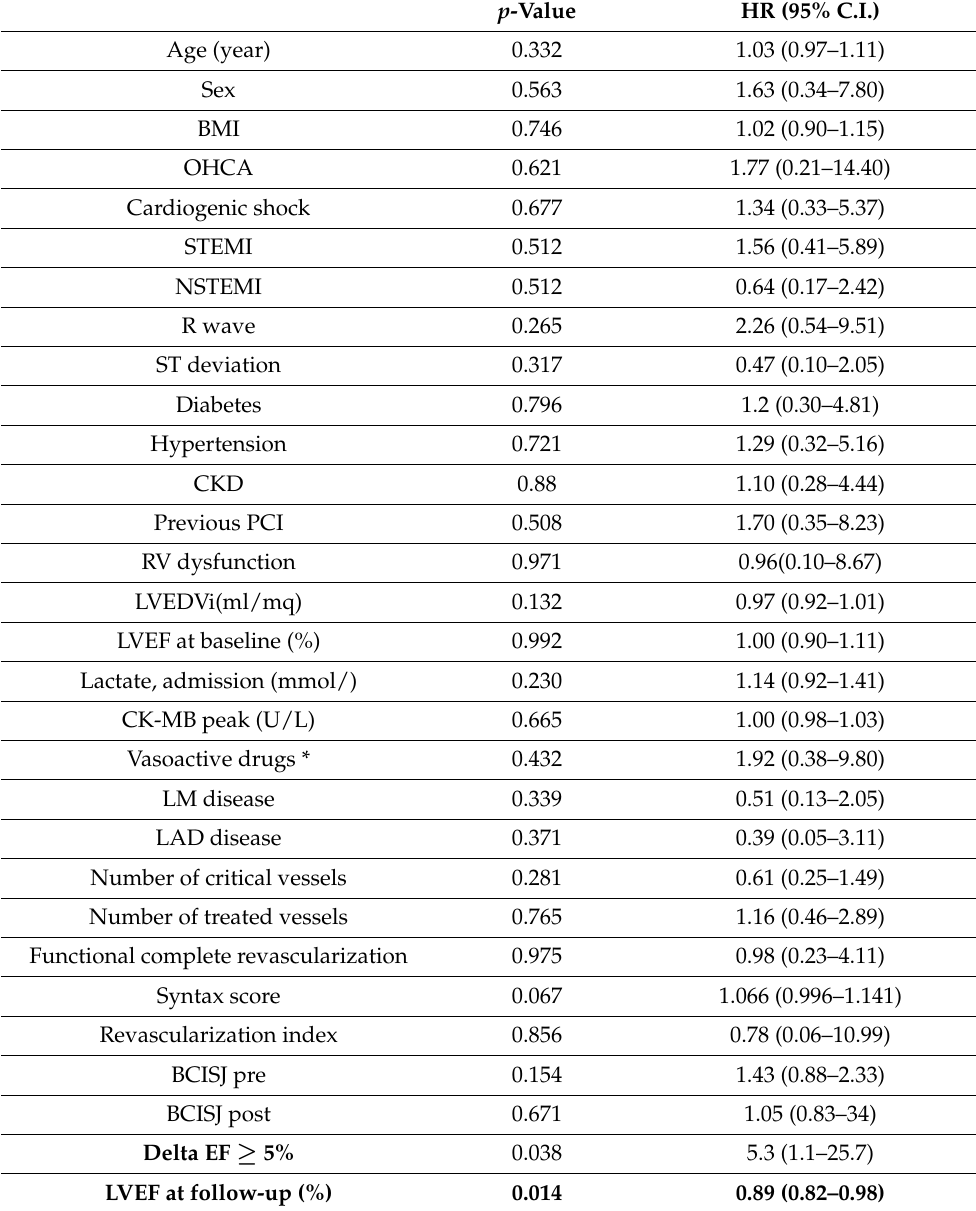
Table 5. Univariate Cox regression analysis of the predictors of three-year